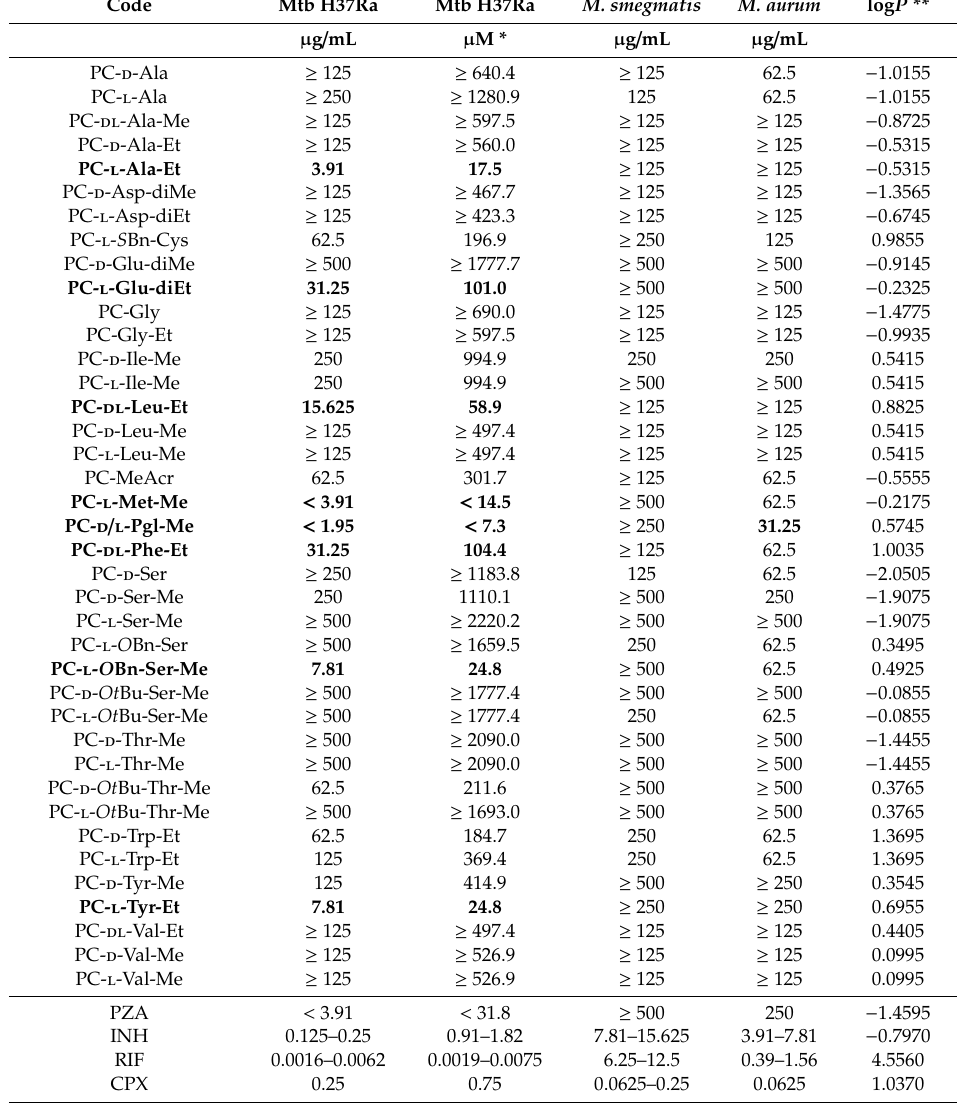
Table 3. Antimycobacterial activities of the tested compounds at pH 6 presented as MIC values, most active compounds are in bold. The chemical structures of the derivatives are presented in Table